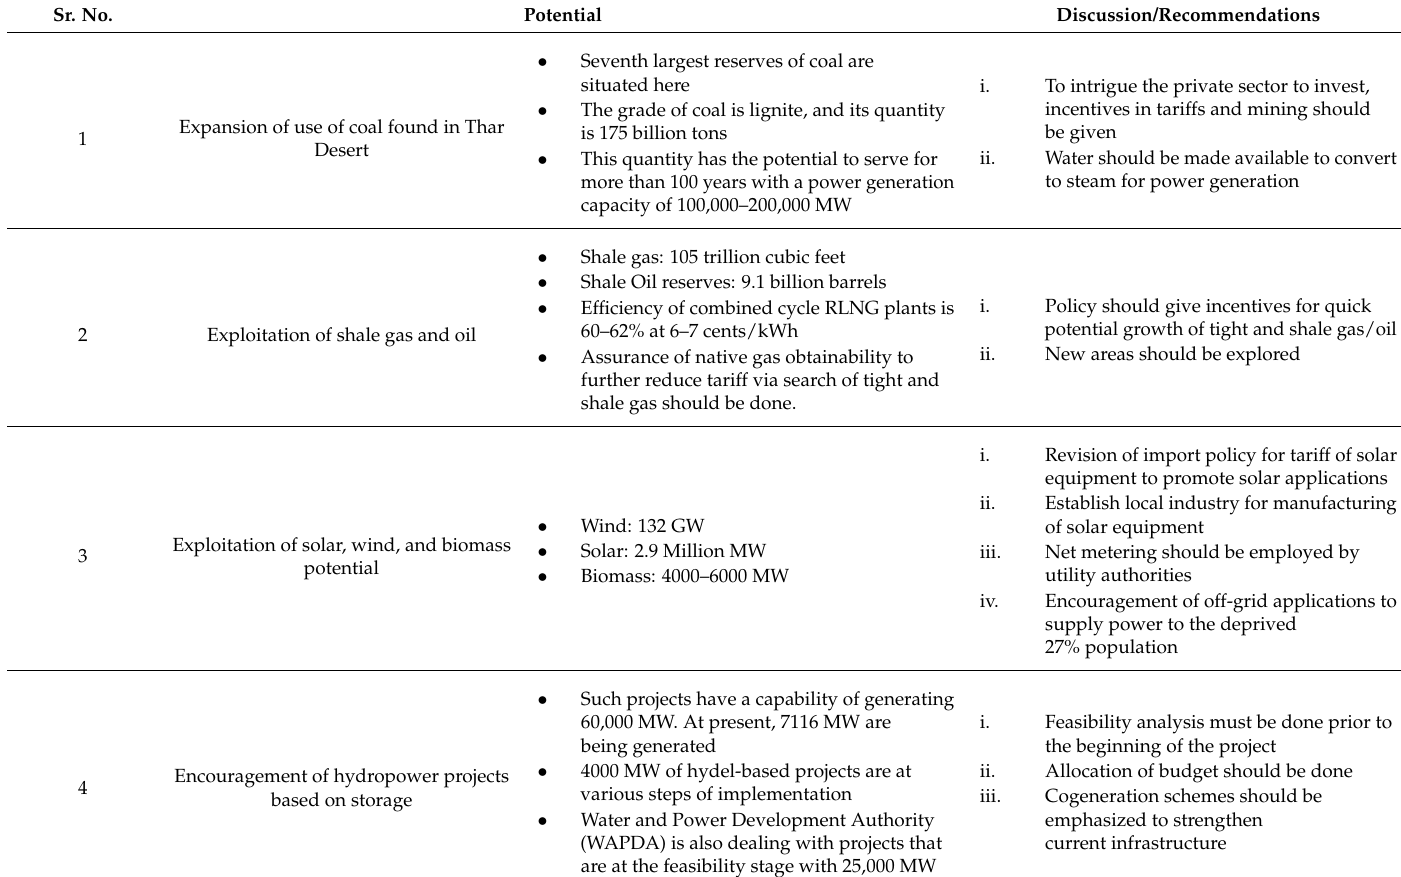
Table 23. Integrated energy policy regarding the national security of